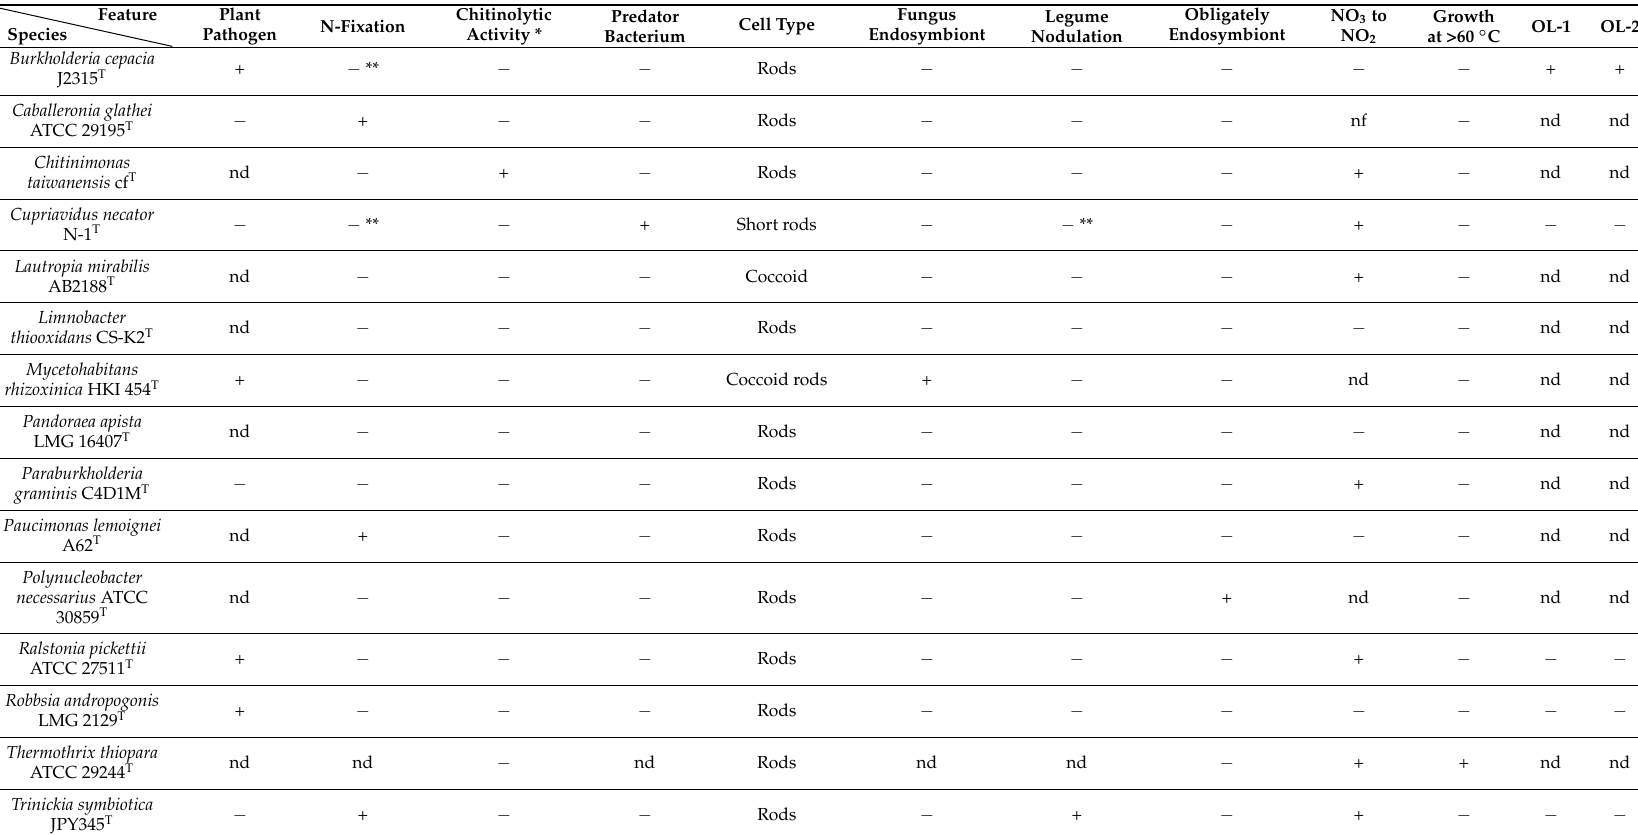
Table 2. The differential phenotypic features among the type species of all the genera in the family Burkholderiaceae